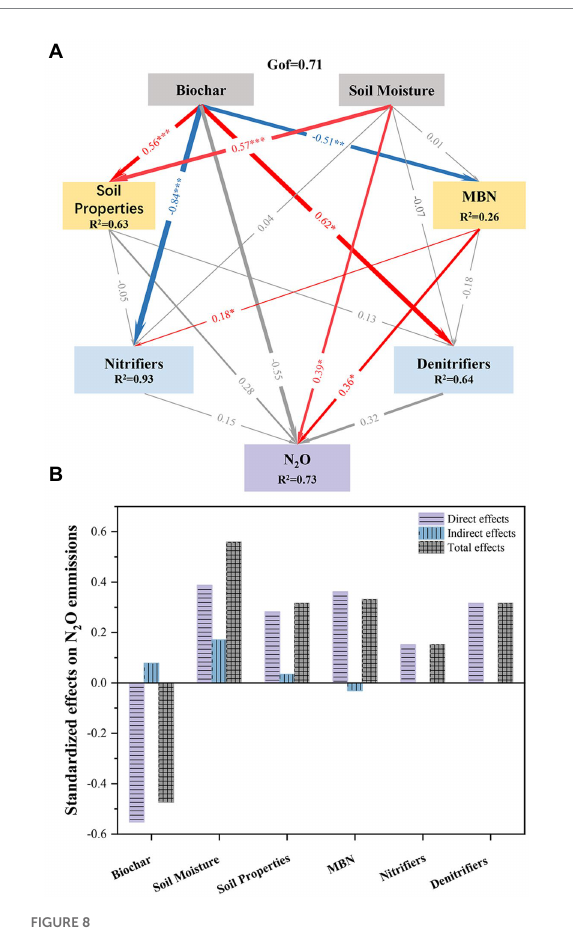
FIGURE 8 PLS-PM showing the direct and indirect effects of different factors on N 2 O emissions with biochar amendment. ( A : PLS-PM showing the relationships among biochar, soil moisture, soil properties, microbial biomass nitrogen, nitrifiers, and denitrifiers with respect to N 2 O emissions. Blue and red arrows indicate positive and negative effects, respectively; the width of arrows indicates the path coefficients; *, **, and *** indicate p < 0.05, p < 0.01, and p < 0.001, respectively; Gof indicates the goodness of fit; B : Standardized direct and indirect mean effects).